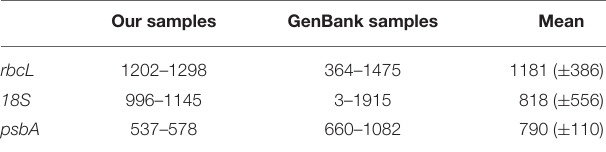
TABLE 4 | Range of sequence base pair lengths for the three genes studied from our samples and those reported from